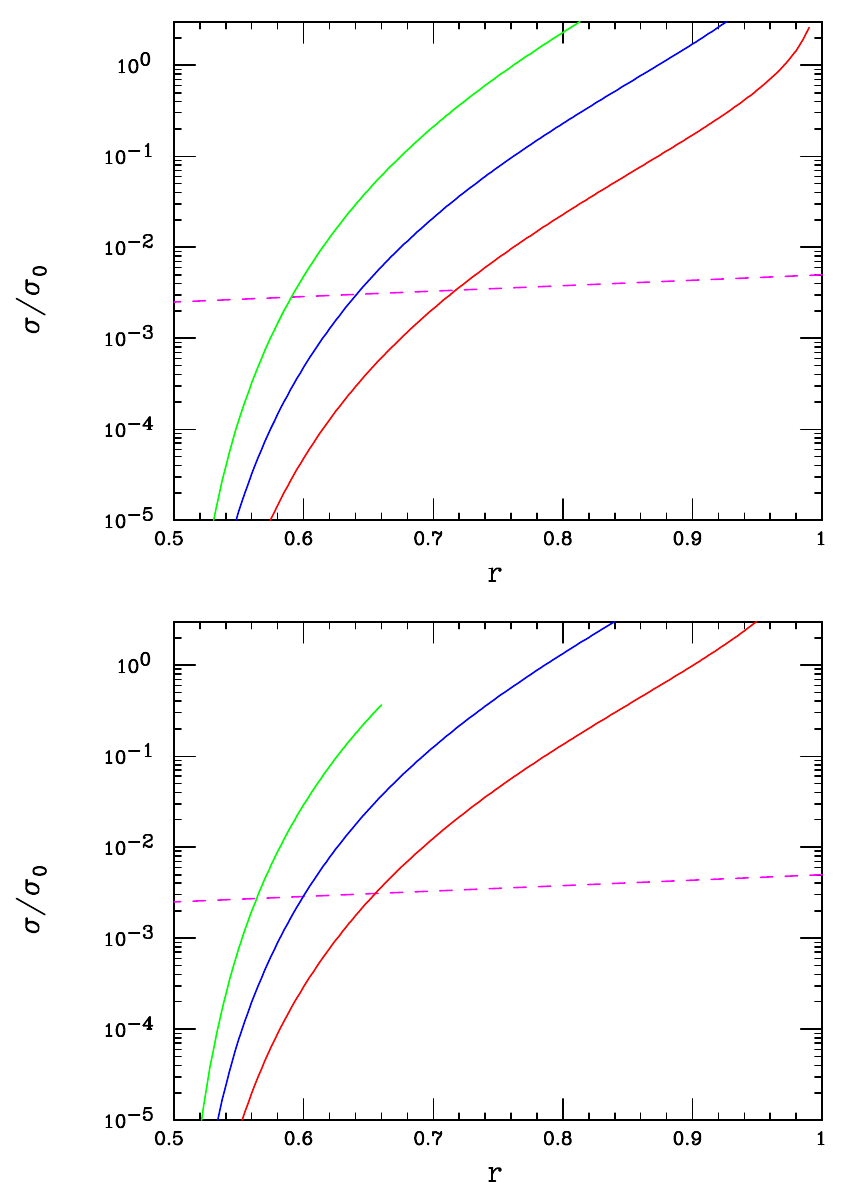
Figure 7 . Same as the previous figure but now assuming that δ = 0 . 15 (Top) or δ = 0 . 2 (Bottom). Note the termination of the curve for (cid:15) = 10 − 4 in the middle of the plot due to the perturbativity constraint on g D